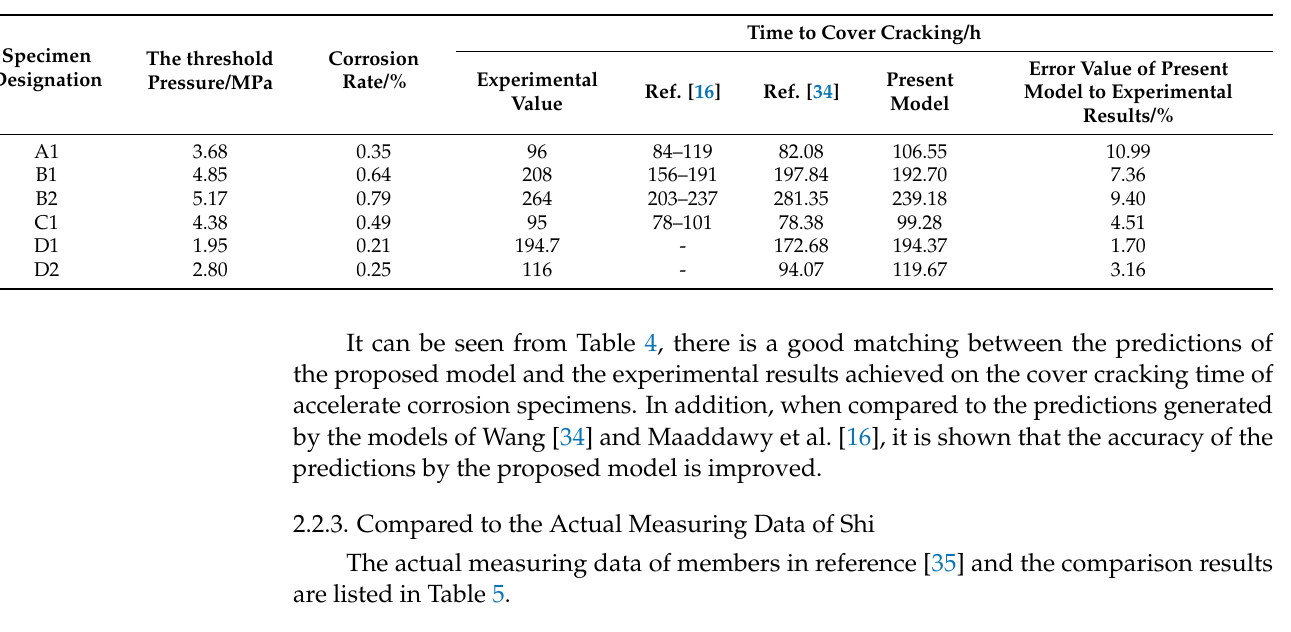
Table 4. Results comparison of present model with experimental prediction and other models.